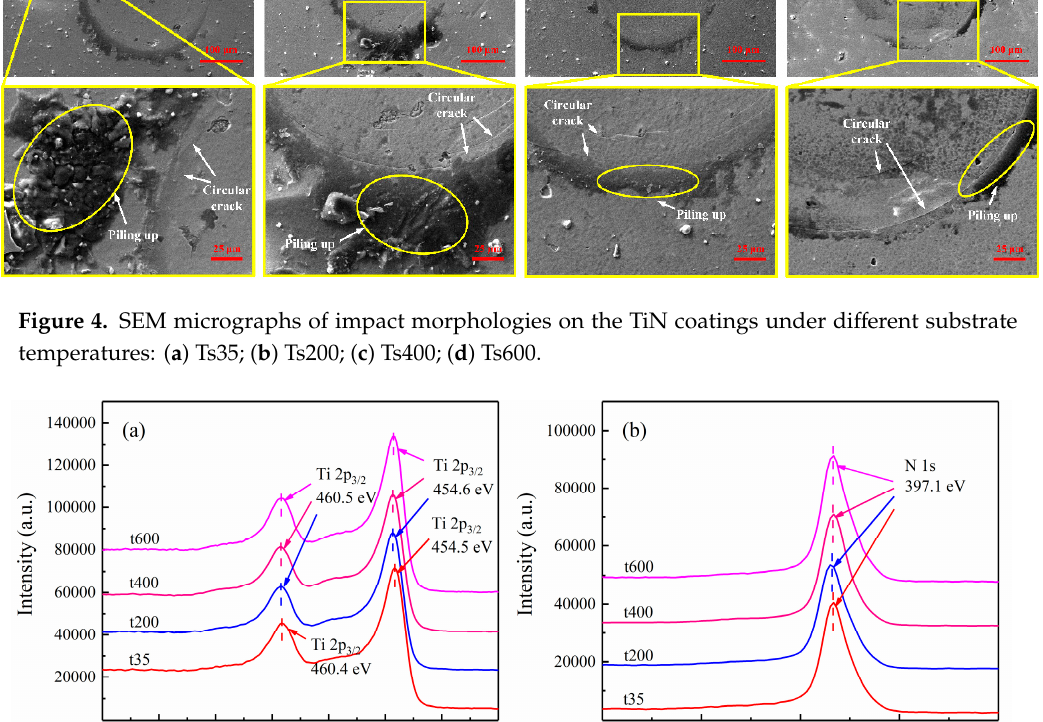
Figure 4. SEM micrographs of impact morphologies on the TiN coatings under different substrate temperatures: ( a ) Ts35; ( b ) Ts200; ( c ) Ts400; ( d ) Ts600.